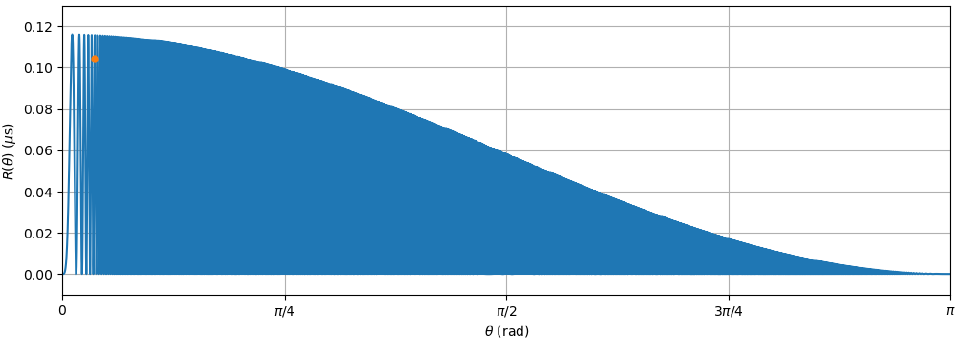
Figure 3. Plot of the R ( θ ) function relative to the SMBHB candidate PKS 2131–021 and the MSP J2145–0750. The horizontal axis indicates the values assumed by the θ variable, expressed in radians. The vertical axis indicates the values assumed by R ( θ ) , expressed in nanoseconds. The orange dot indicates the value assumed by the R ( θ ) function when θ coincides with the actual angle between the SMBHB candidate PKS 2131–021 and the MSP J2145–0750, which is θ =